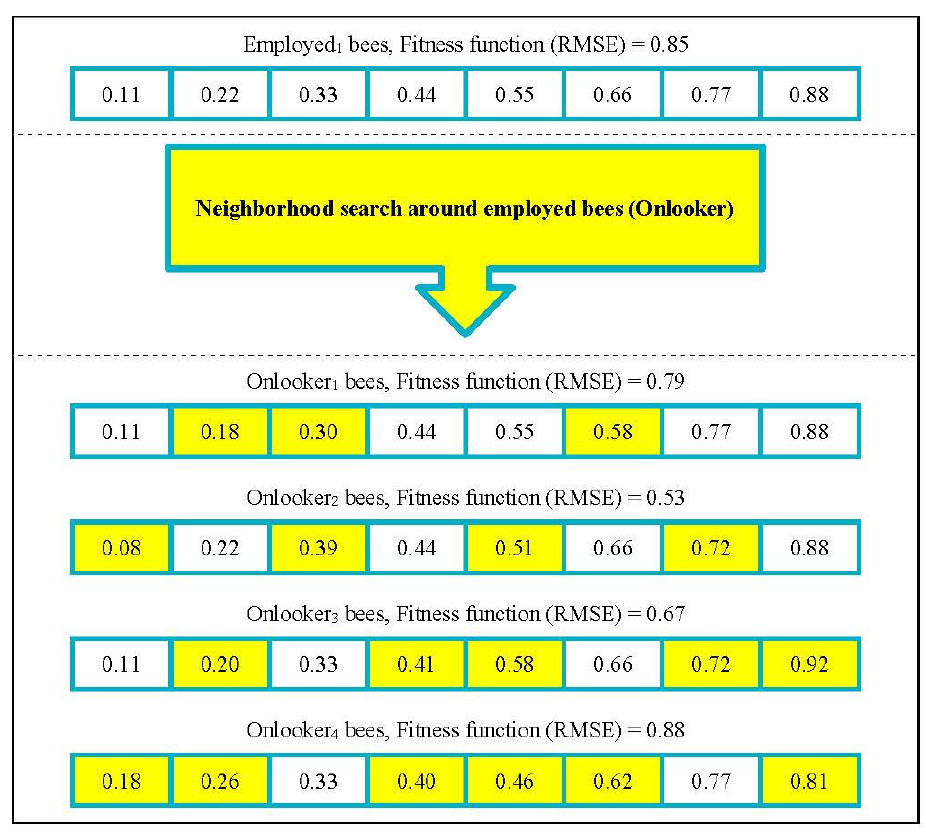
Figure 2. The example of a neighborhood search around employed bees.